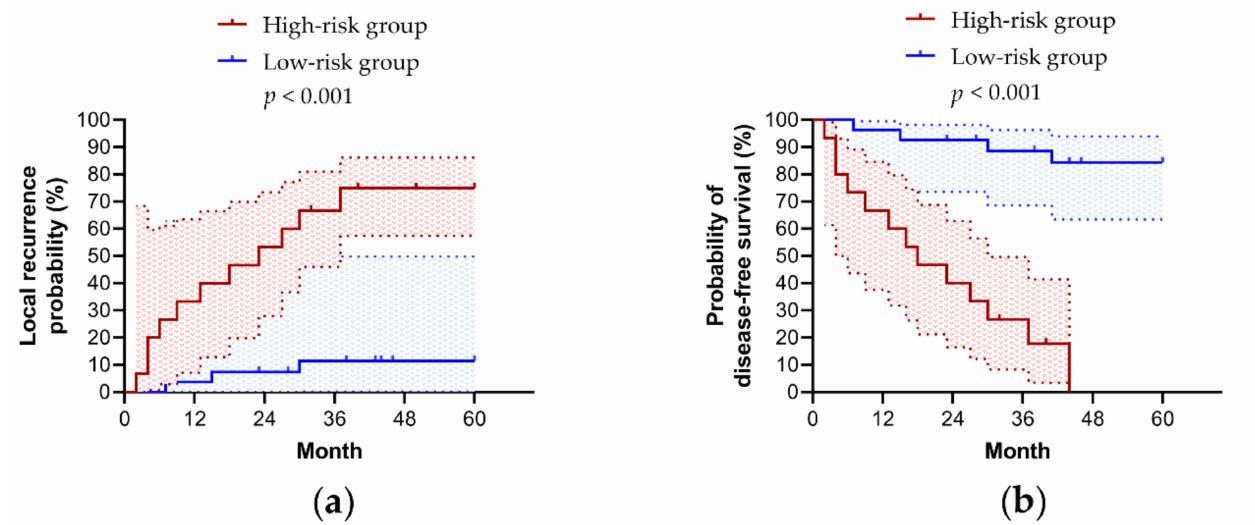
Figure 3. Kaplan-Meier curves of the predictive models of five-year prognoses. Comparison of ( a ) five-year local recurrence rates and ( b ) five-year disease-free survival rates between high-risk and low-risk groups using log-rank